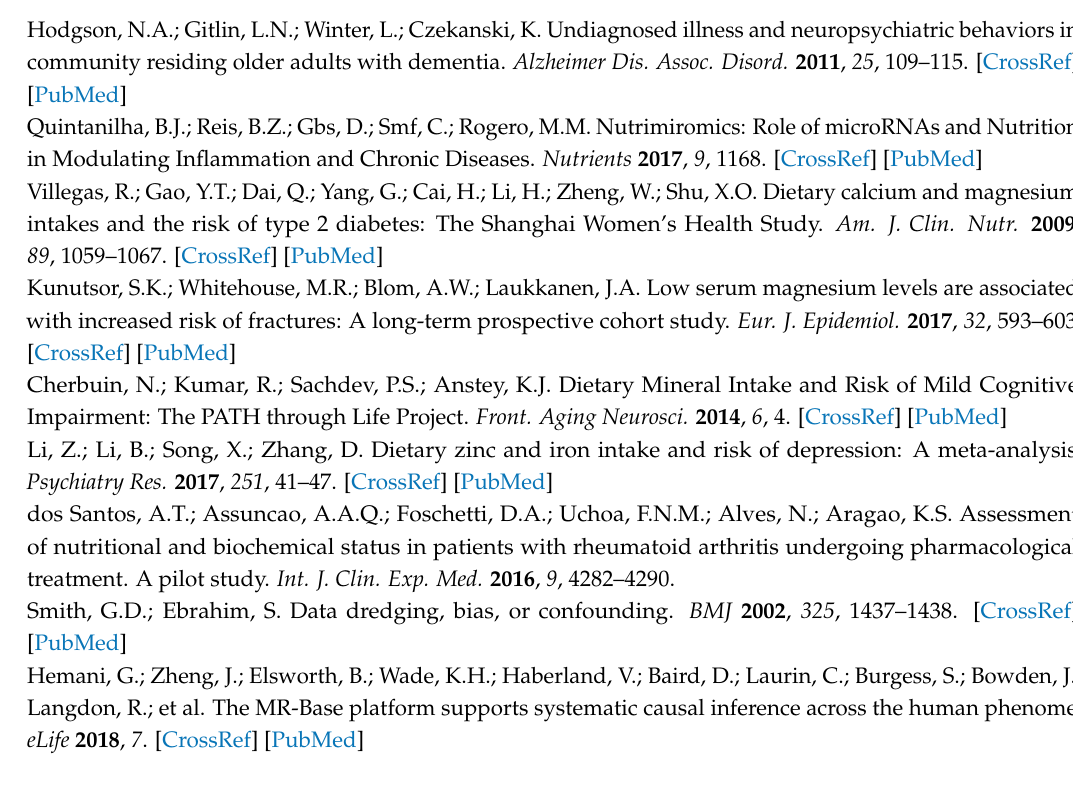
Table S9: Summary statistics for the genetic variants associated with the exposure factors investigated for an association with PD in the present Mendelian randomization study; Table S10: Summary statistics for the genetic variants associated with the exposure factors investigated for an association with MDD in the present Mendelian randomization study; Gene